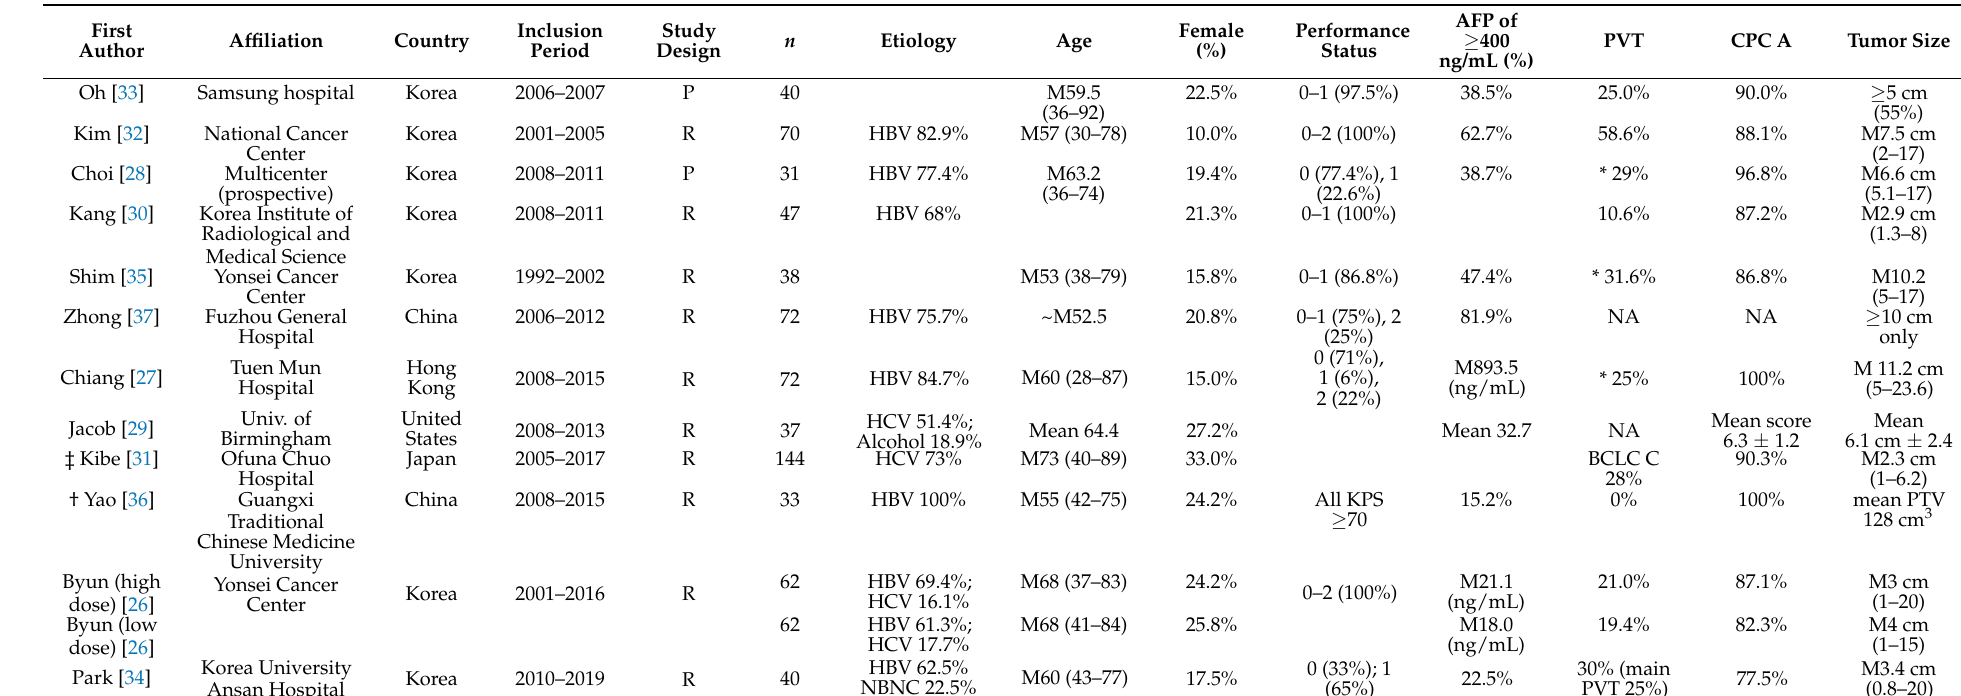
Table 1. Selected published studies with correlating